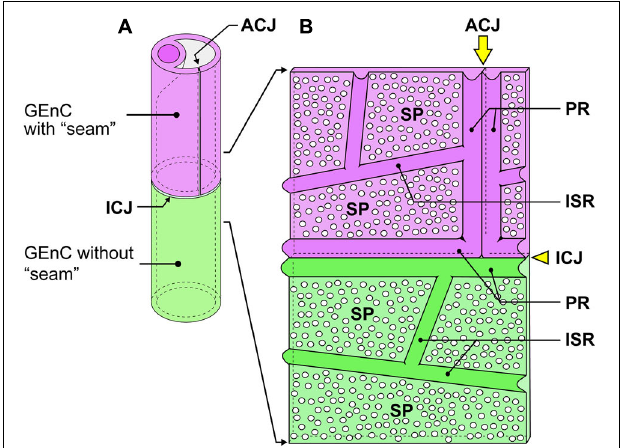
FIGURE 6 | Schematic diagram of the cytoplasmic ridges and cellular junctions in the urinary region. (A) A green glomerular endothelial cell (GEnC) forms a capillary tube without an autocellular tight junction. This type of capillary is the so-called “seamless capillary”; a purple GEnC makes an autocellular junction (ACJ) to form a capillary tube. The ACJ is usually along the longitudinal axis of the capillary. Two GEnCs are connected by an intercellular junction (ICJ), which is usually aligned perpendicularly to the longitudinal axis of the capillary. (B) Luminal view of the adhering region between purple and green GEnCs. The capillary tube shown in (A) is cut lengthwise and unfolded. The peripheral ridge (PR) forms the cell periphery of GEnCs; thus, two PRs of adjacent GEnCs are parallel. The intersieve ridge (ISR) is between the sieve plates (SPs), which are highly attenuated and